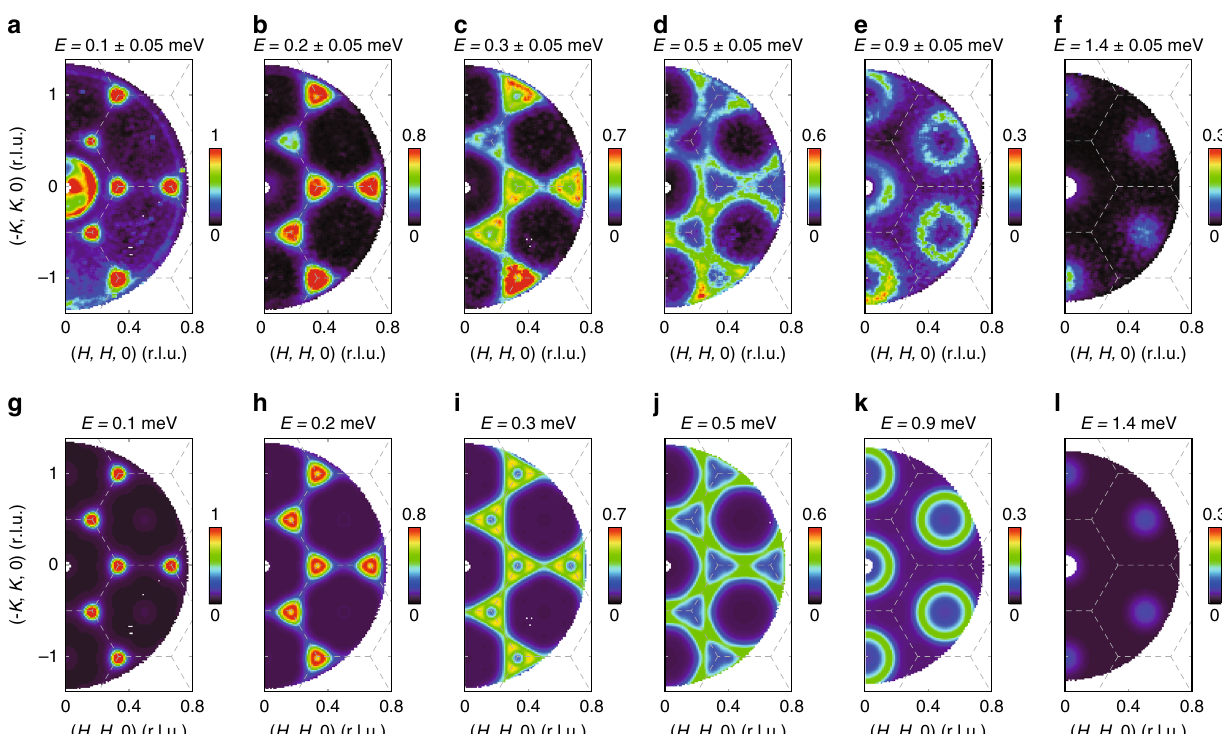
Fig. 2 Measured and calculated momentum dependence of the spin excitations in TmMgGaO 4 at the indicated energies and T = 0.05 K. a – f Raw contour plots of the constant energy images at T = 0.05 K. The signals near Q = (0, 0, 0) in a are due to the elastic contamination from the sample environment close to the direct beam. g – l Calculated spin excitations using the model speci fi ed in the text. The dashed lines indicate the zone boundaries. The measurements were performed on LET spectrometer with E i = 4.8 meV. The color bars indicate scattering intensity in arbitrary unit in linear